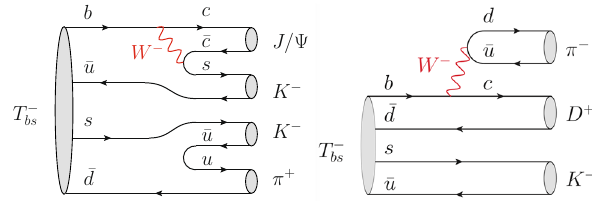
Fig. 3 Topological diagrams of weak decays of the bs ¯ u ¯ d tetraquark into J /(cid:7) K − K − π + and D + K − π − , respectively